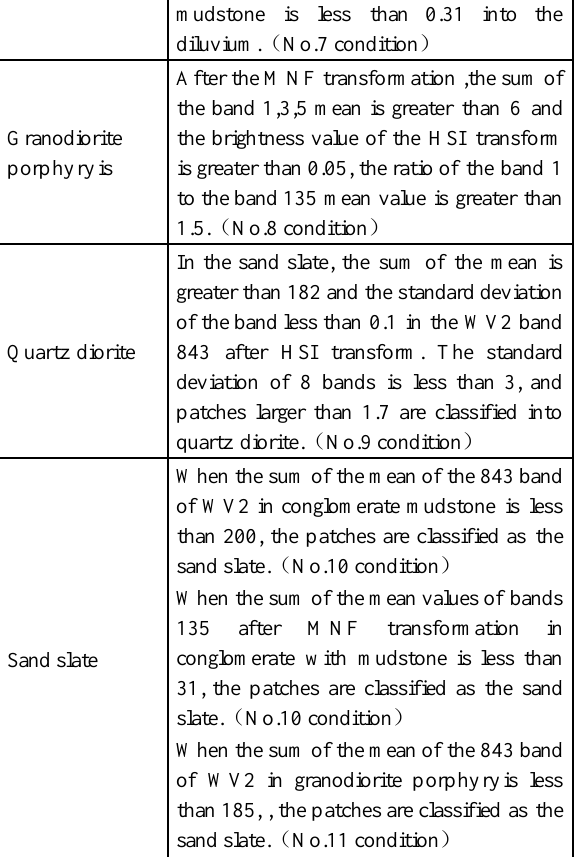
Table 1. Geological information extraction rules